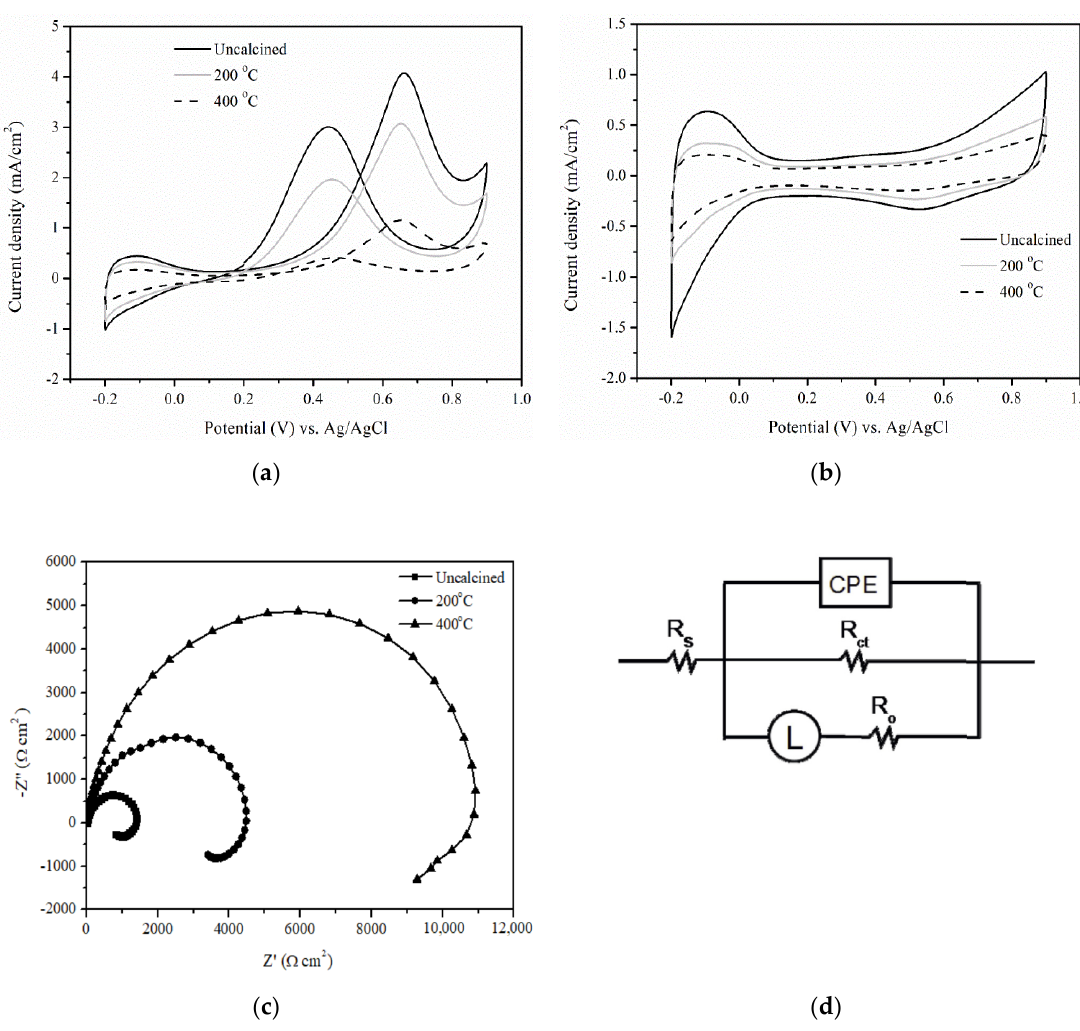
Figure 1. ( a ) CV curves in 1 M CH 3 OH + 0.5 M H 2 SO 4 , ( b ) in 0.5 M H 2 SO 4 , ( c ) EIS (electrochemical impedance spectra) of 20%Pt-Ba 0.5 AlO x / C prepared with Ba 0.5 AlO x calcined at di ff erent